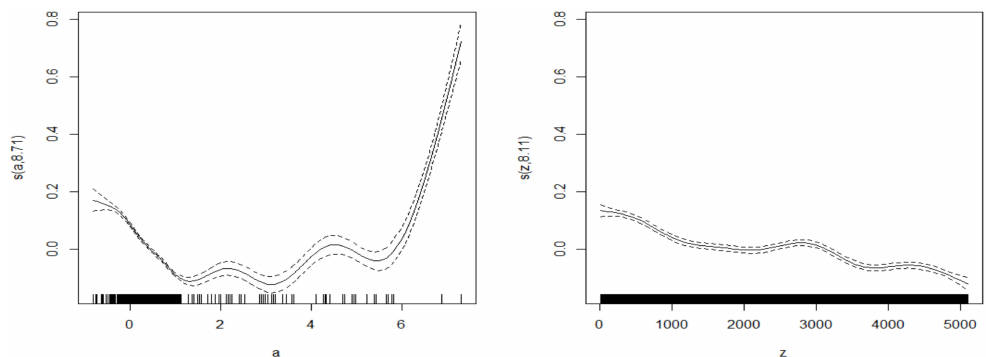
Figure 4. Smoothed single index function of weather variables and cardiovascular, a = β 1 x 1 + β 2 x 2 + β 3 x 3 + β 31 ( x 3 − θ ) + ( left ) and smoothed function of time ( right